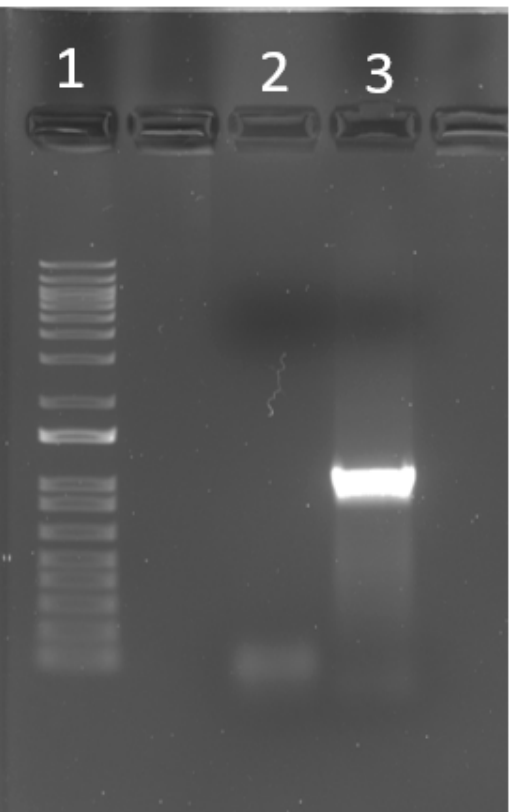
Figure 1. Visualization of polymerase chain reaction (PCR) product run on a 1% agarose gel of PCR targeting open reading frame (ORF) a and b (USDA reference genome coordinates 22,364–23,364). The amplicon size is 1000 bp. The DNA ladder used was 1 kilo base pairs plus (kb+). Lane 1 is the DNA ladder. The lane labeled 2 is a negative control. Lane labeled as 3 is a known positive sample to an infectious laryngotracheitis virus (ILTV).